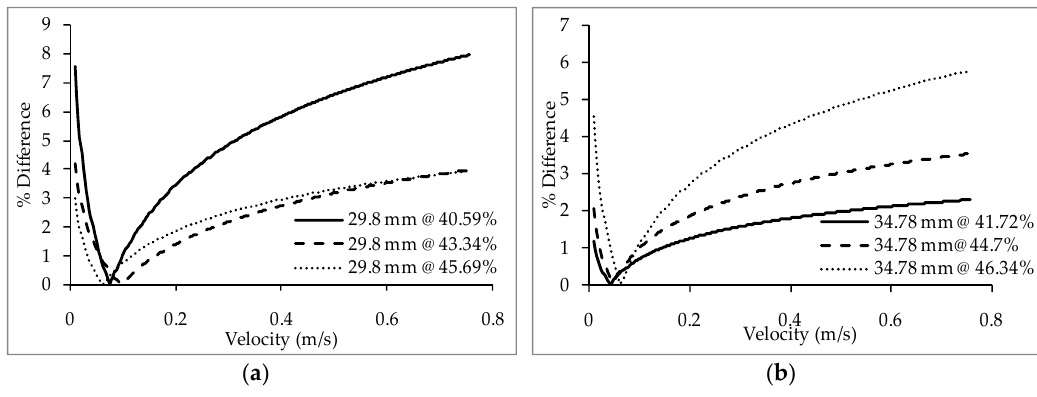
further in the next section.